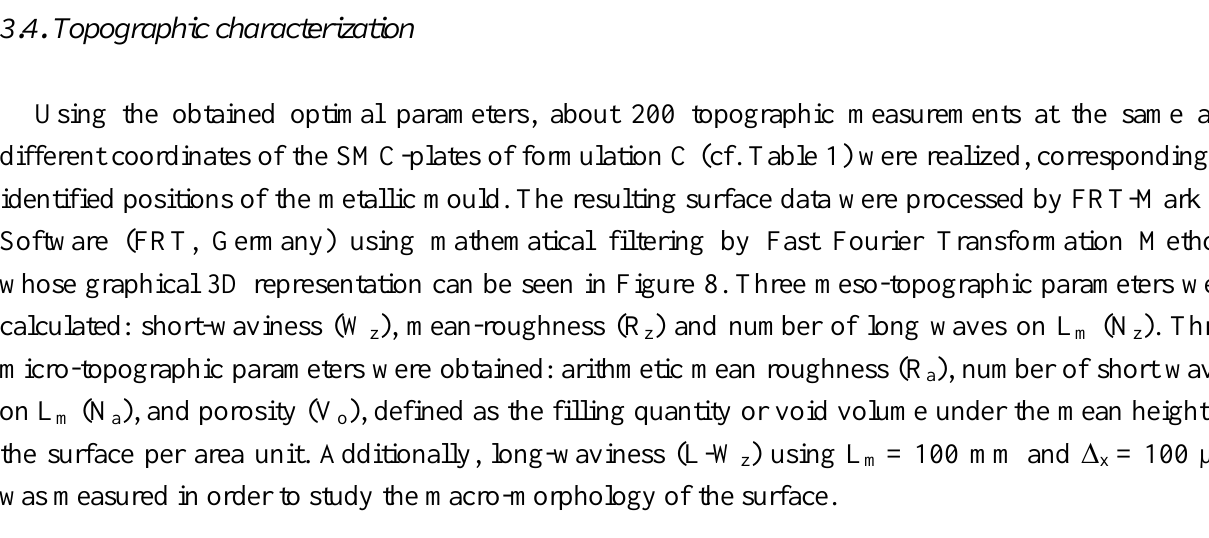
Table 2. Calculated parameters of seven independent measurements (different positions) on the same SMC plate (L